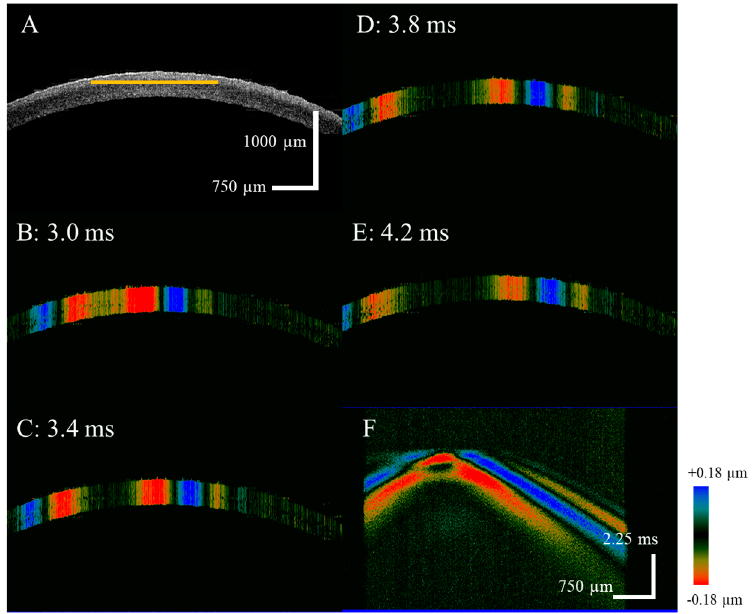
Figure 2. The OCE experiment results of the normal cornea, ( A ) is the corneal 2D structure image, ( B – E ) is the axial vibration with different times, and ( F ) is the spatial-temporal displacement